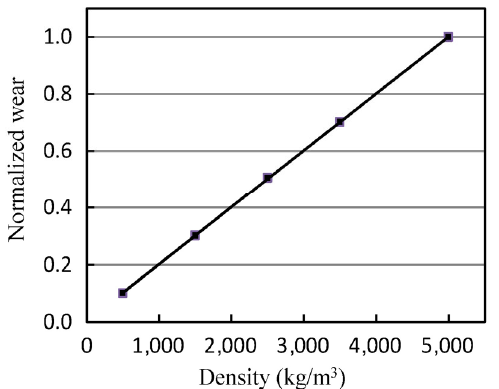
Fig. 7 Variations of the wear versus the particle density ( 30  ° and the other variables are at the reference values).